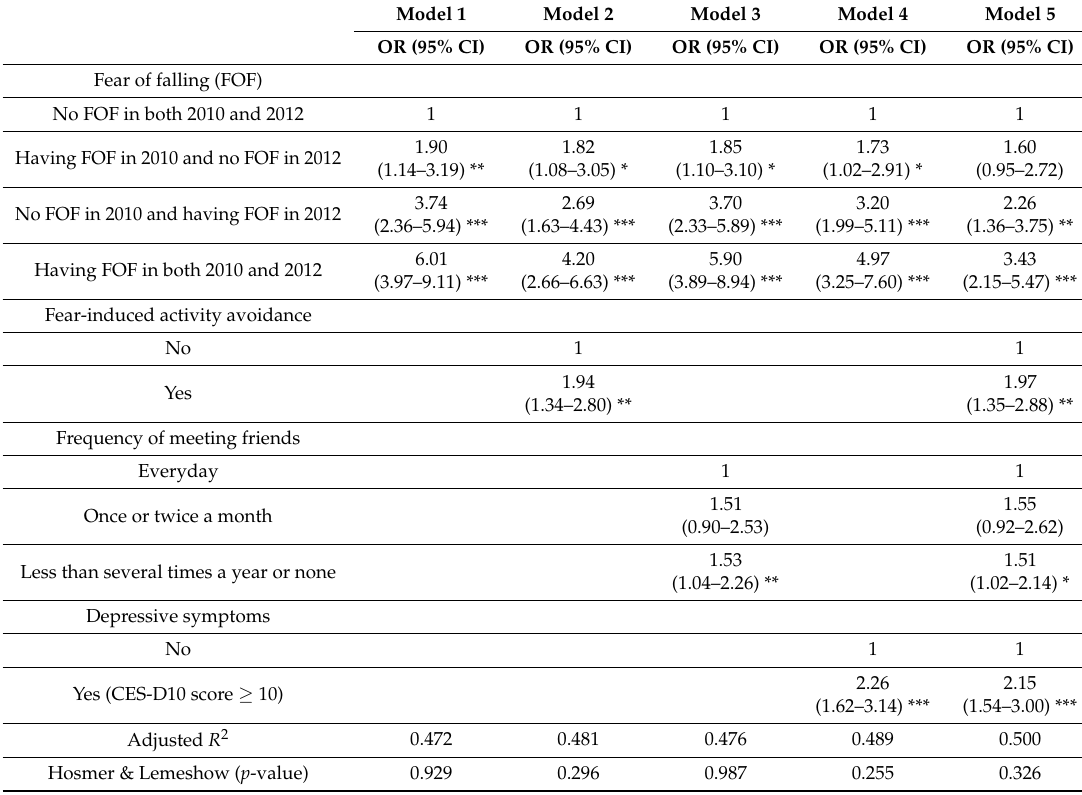
Table 3. Odds ratio (OR) a and 95% confidence interval (CI) for functional decline among Korean women aged 70 years or